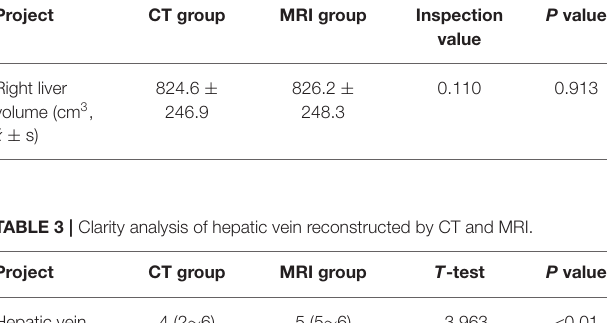
TABLE 2 | Right lobe volume measured by CT and MRI reconstruction. Project